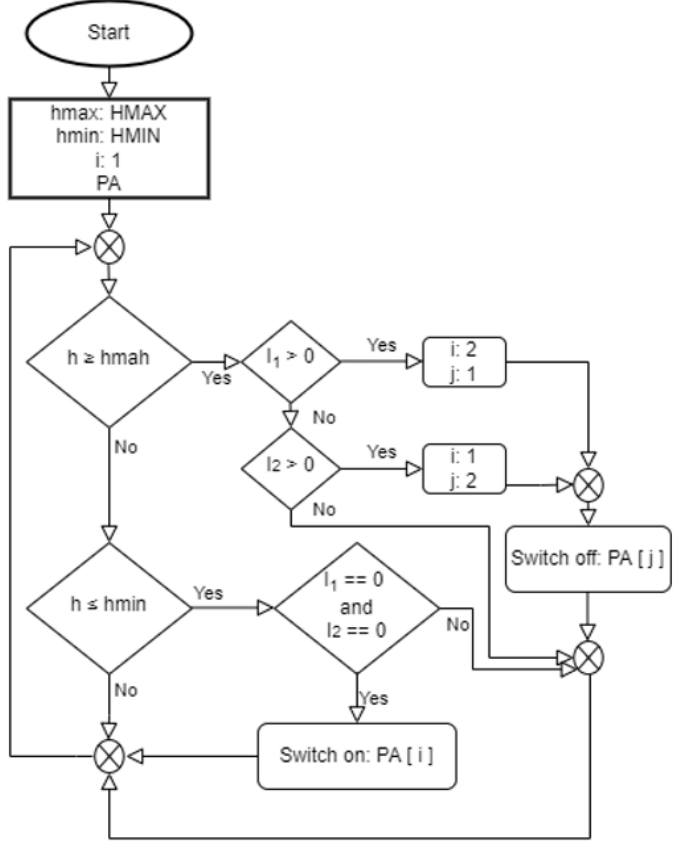
Figure 15. A part of the control algorithm allowing cyclic PU operation.